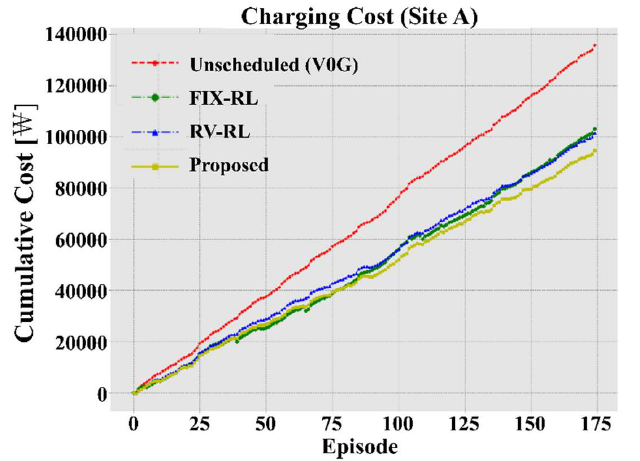
Figure 8. Cumulative charging cost of the proposed method and the benchmarks for site A. Energies 2020 , 13 , x FOR PEER REVIEW 13 of 18